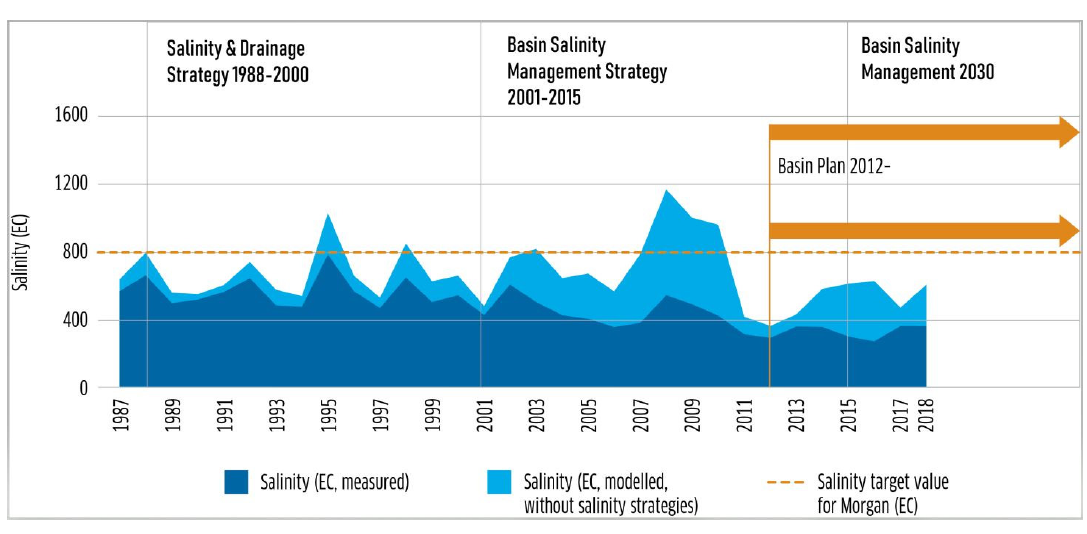
Figure 8. Measured and modelled annual average salinity in the River Murray at Morgan showing the effect of the salinity management strategies. (Source: MDBA).